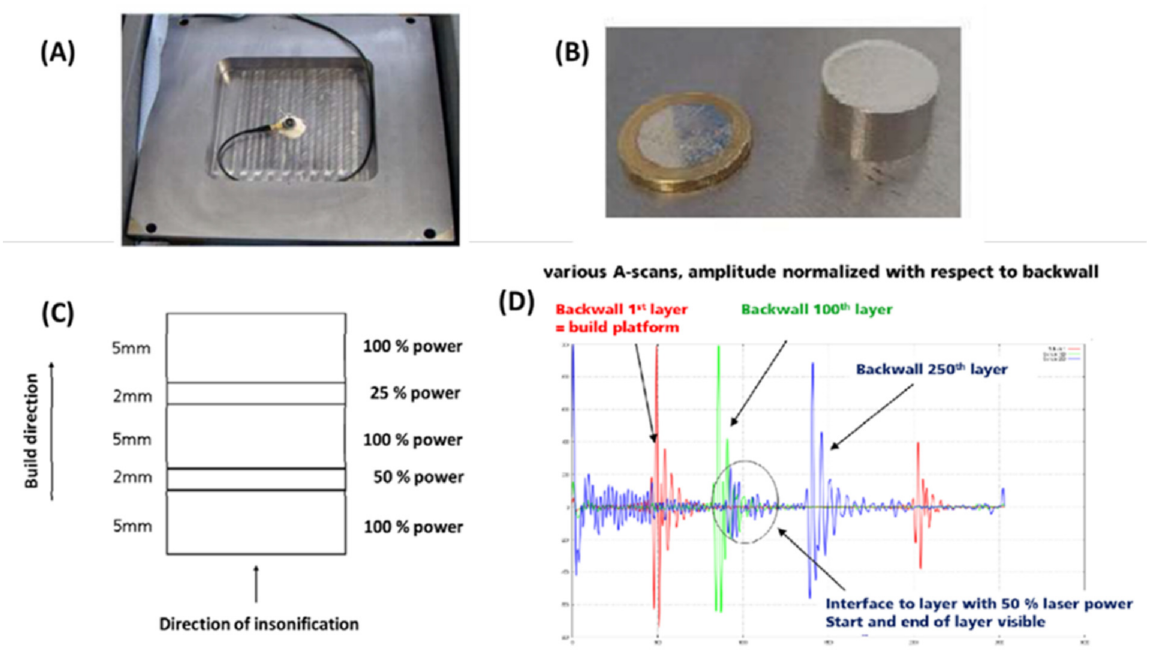
Figure 14. In-situ monitoring of the SLM printing process. ( A ) Attached ultrasound probe on the backside of the printing substrate. ( B ). The printed sample. ( C ) Printed object region demonstration. ( D ) The detected reflection signal from the interfaces between the layers in ( C